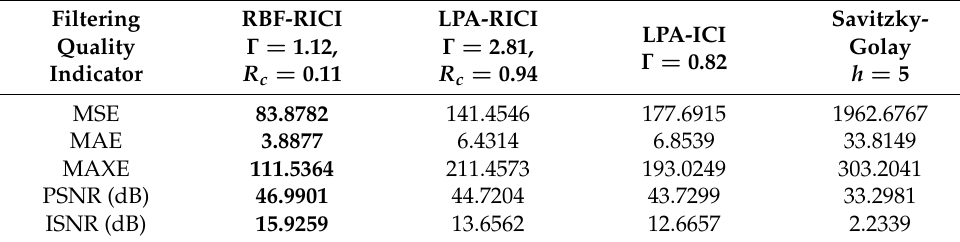
Table 36. Sing signal (SNR = 5 dB)—Filtering results.